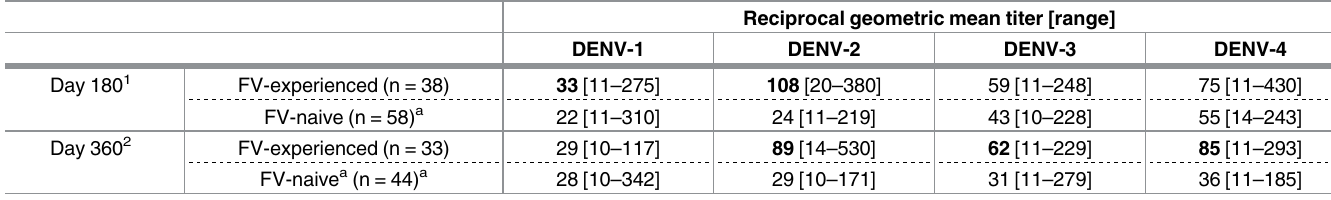
1 Comparison of mean neutralizing antibody titer at Day 180 (6 months after dose 1) post-TV003) between subjects who were flavivirus-exposed versus flavivirus–na ï ve at Day 0: DENV-1 ( P = 0.03), DENV-2 ( P < 0.0001), DENV-3 ( P = 0.93), DENV-4 ( P = 0.56). 2 Comparison of mean neutralizing antibody titer at Day 360 (6 months after dose 2) post-TV003) between subjects who were flavivirus-exposed versus flavivirus–na ï ve at Day 0: DENV-1 ( P = 0.56), DENV-2 ( P < 0.0001), DENV-3 ( P = 0.02), DENV-4 ( P = 0.01). Significant values in BOLD (At P < 0.05 level after adjusting for multiple comparisons).